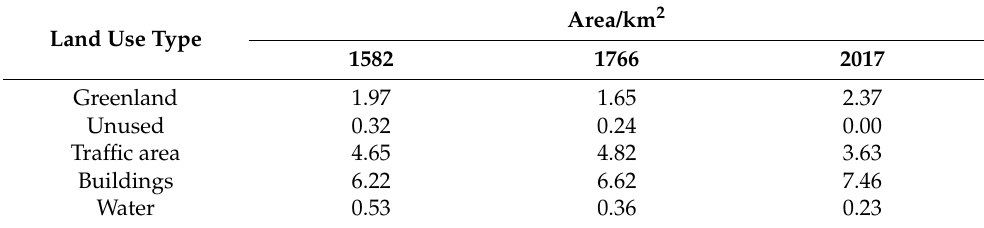
Table 9. Land Use Area